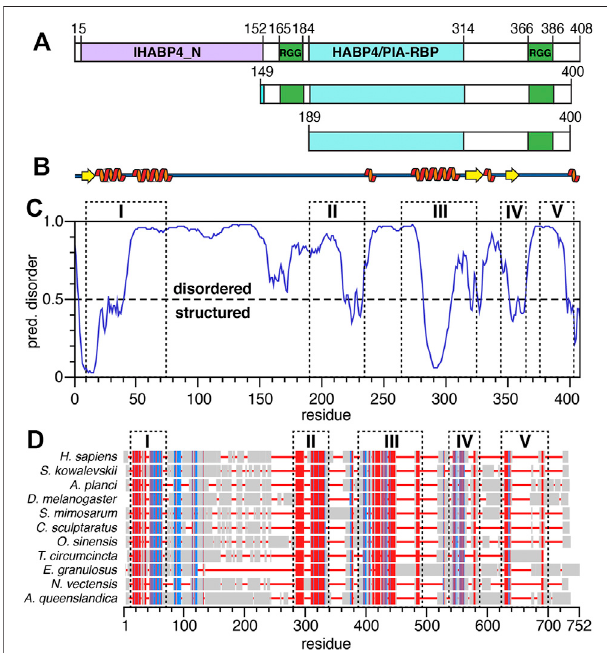
FIGURE 1 | Structural predictions and sequence alignments of human SERBP1. (A) Schematic representation of the three SERBP1 constructs. Green boxes represent the RG/RGG repeats, purple and cyan boxes represent the IHABP4 and HABP4 homology domains, respectively. Sequence numbering is from human SERBP1 and indicate the starting and ending amino acids of each domain. (B) Representation of SERBP1 secondarystructurepredictedbyPSIPRED.Orangespiralsandyellowarrows represent α -helices and β -strands, respectively. (C) Disorder plot of SERBP1 predicted by the DISOPRED3 algorithm. Residues with predicted values greaterthanthe0.5thresholdarepredictedasdisordered,whileresidueswith values less than the threshold are predicted as structured. (D) Sequence alignment of the human SERBP1 sequence with invertebrate homologues. Red denotes conserved residues, blue indicates semi-conserved residues, grey boxes indicate non-conserved residues and red lines indicate gaps. Dashed boxes labeled with roman numerals align the regions of high sequence conservation with predicted regions of order (panel C)